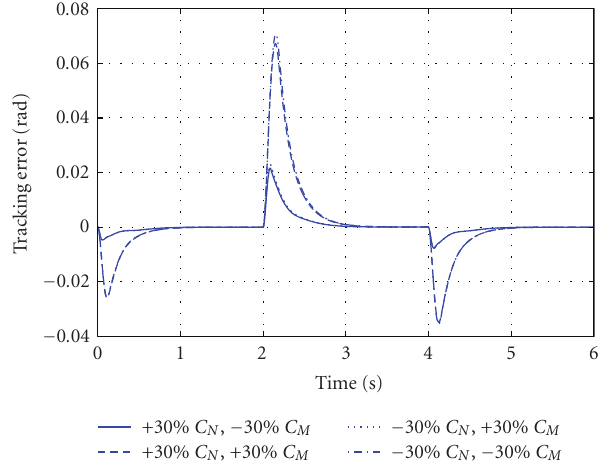
Figure 4: Tracking error for various possible parameter uncertain-